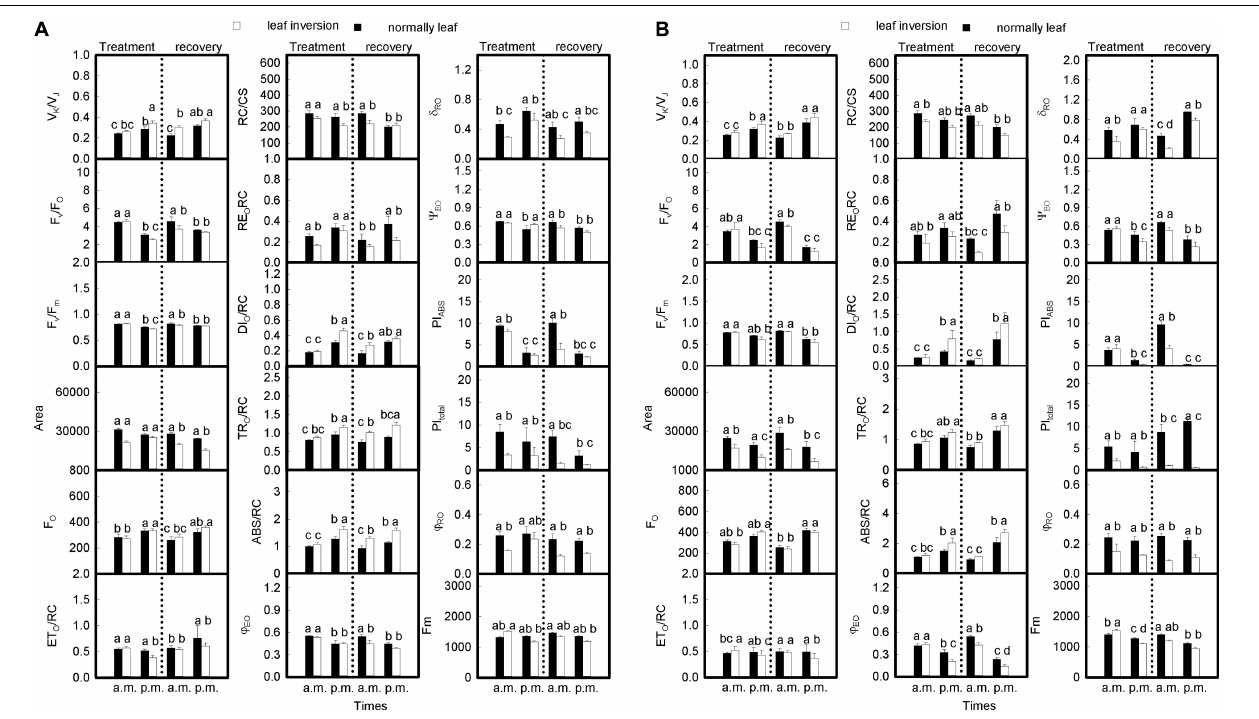
FIGURE 5 | The JIP-test parameters of soybean leaf inversion (10 days) and recovery (15 days) evaluated during 2020 (A) and 2021 (B) at 9 a.m. and 4 p.m.; L, the combined stress of elevated temperature and high light; T, leaf inversion; F v /F m , maximum quantum yield of photosystem II (PSII); ABS/RC, absorption flux per reaction center (RC) at t = 0; DI O /RC, Dissipated energy flux per RC at t = 0; TR O /RC, Trapped energy flux per RC at t = 0; ET O /RC, Electron transport flux per RC at t = 0; (cid:57) EO , Probability that a trapped exciton moves an electron into the trapped electron transport chain beyond Q A - ; ϕ EO , Quantum yield for electron transport at t = 0; δ RO , Efficiency with which an electron can move from the reduced intersystem electron acceptors to the photosystem I (PSI) end electron acceptors; ϕ RO , Quantum yield for the reduction of end acceptors of PSI per photon absorbed; V K /V J , Limitation/inactivation and possible damage of the oxygen-evolving complex; F V /F O , maximum ratio of quantum yields of photochemical and concurrent non-photochemical processes in PSII; Area, Density area over the chlorophyll a fluorescence transient delimited by a horizontal line at F m ; F O , Minimum fluorescence, when all PSII RCs were open; F m , Maximum fluorescence, when all PSII RCs were closed; RC/CS, Density of active RCs (Q A reducing RCs) per cross-section at t = 0; PI ABS , performance index on absorption basis; PI total , efficiency of energy conservation from absorbed photons to the reduction of PSI end acceptors. Data are expressed as means ± SEs ( n = 5). Different letters represent significant differences ( P < 0.05) between treatment and time of measurement. The vertical dotted line separates the treatment from the